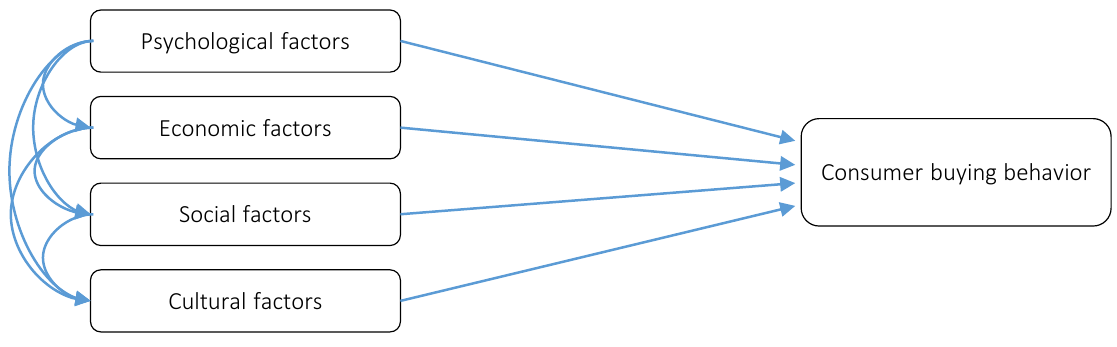
Figure 1. Conceptual